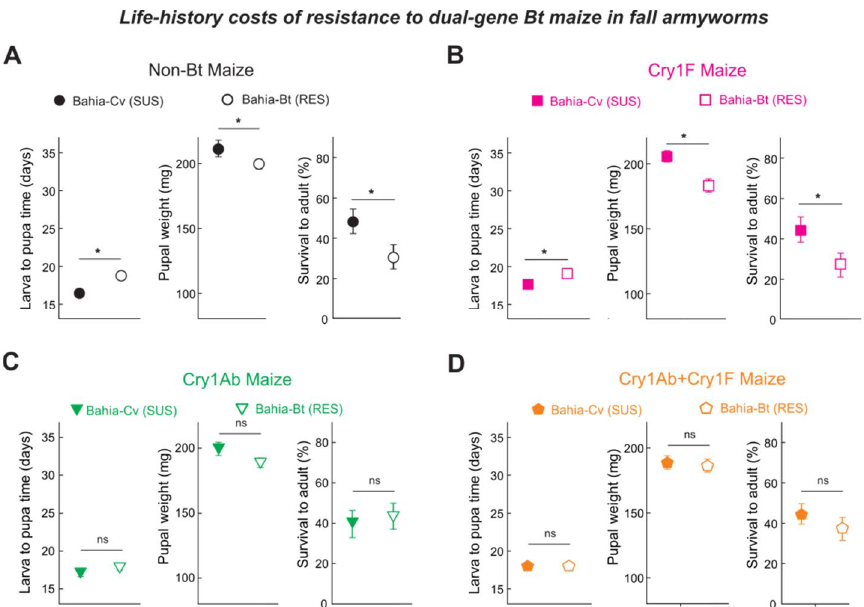
Figure 1. Life-history costs of resistance to dual-gene Bt maize (Cry1A.105+Cry2Ab2) in the invasive fall armyworm ( Spodoptera frugiperda ). Larvae ( n = 160) of a Bt-resistant population (Bahia-Bt, black symbols) and susceptible population (Bahia-Cv, white symbols) were reared on the foliage of four maize cultivars (panels A – D ), and their life-history traits were recorded. Data are means ± standard errors. Asterisks indicate significant differences (ANOVA, p < 0.05) between the insect populations. ns: Not Significant.